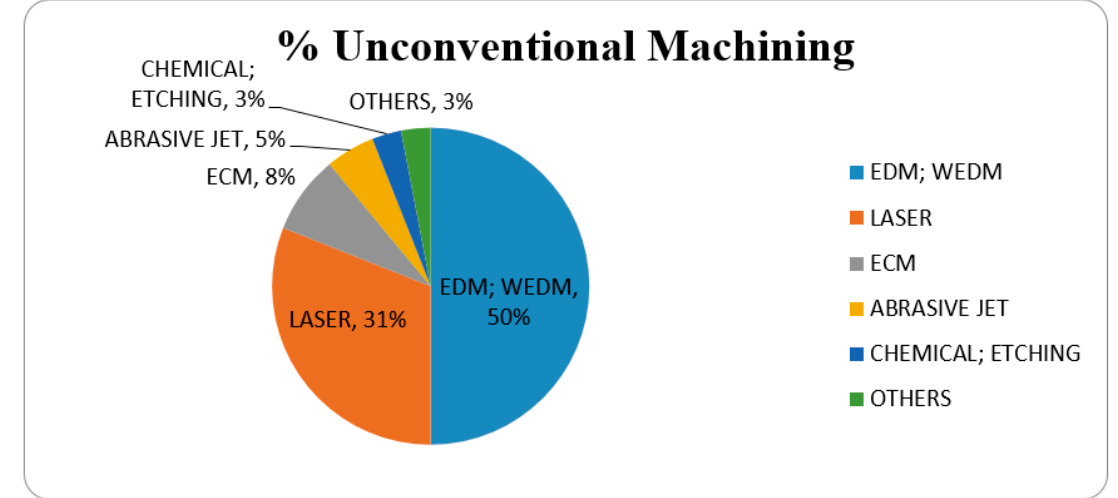
Figure 1. Application of unconventional machining for high hardness materials.